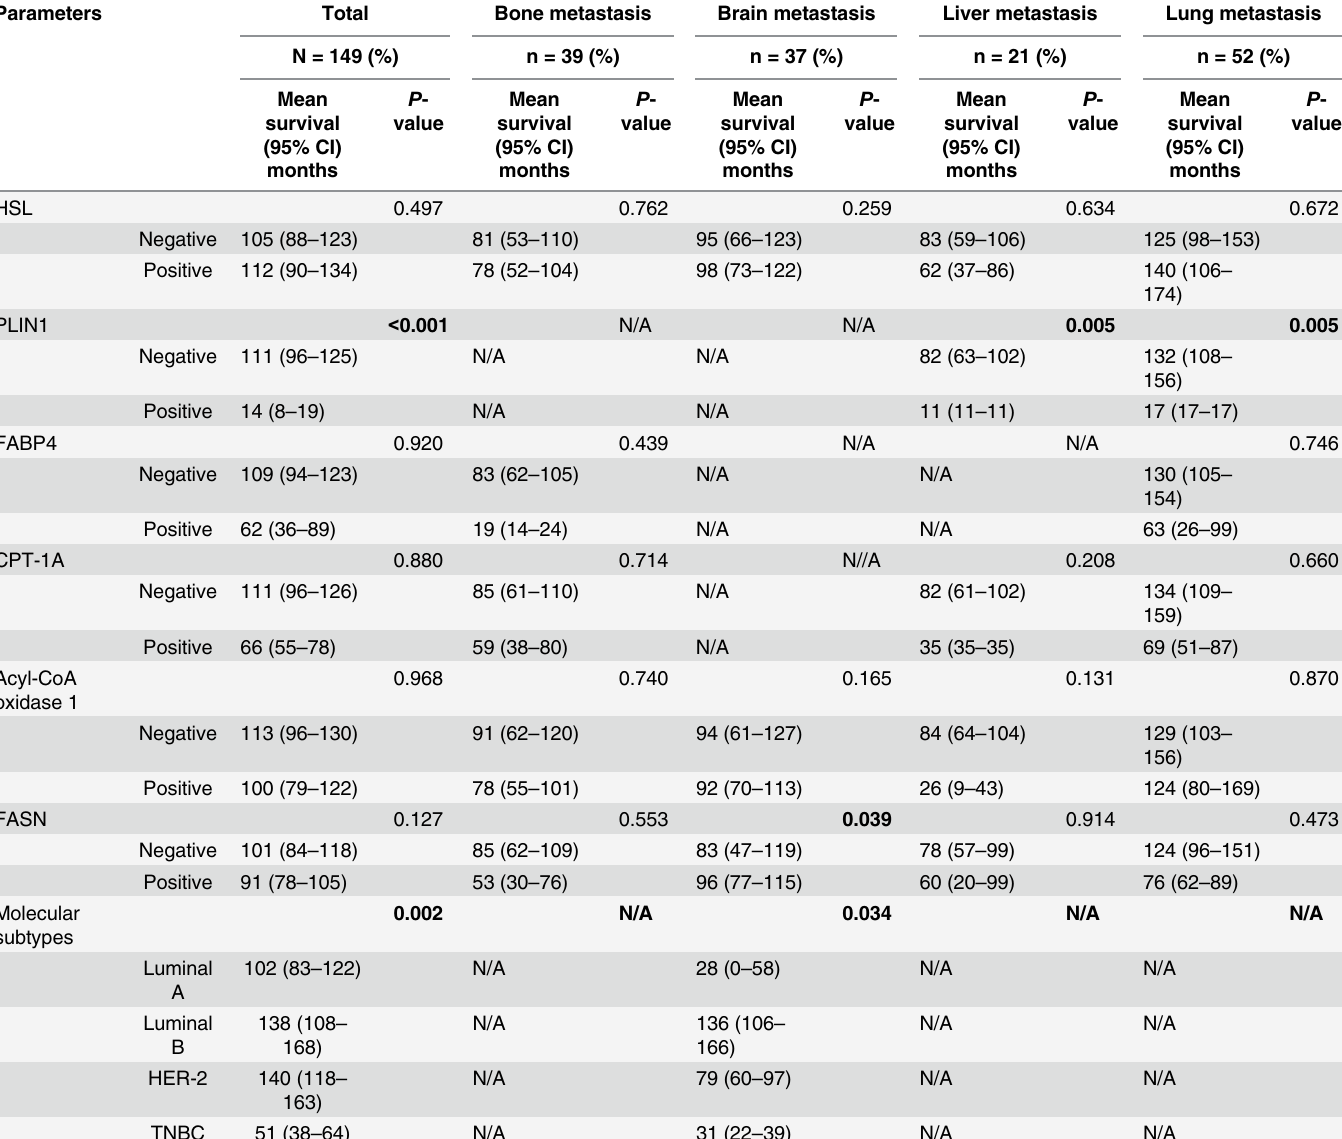
Table 5. Univariate analysis of the association between expression levels of metabolism-related proteins in metastatic breast cancers and overall survival by the log-rank test.